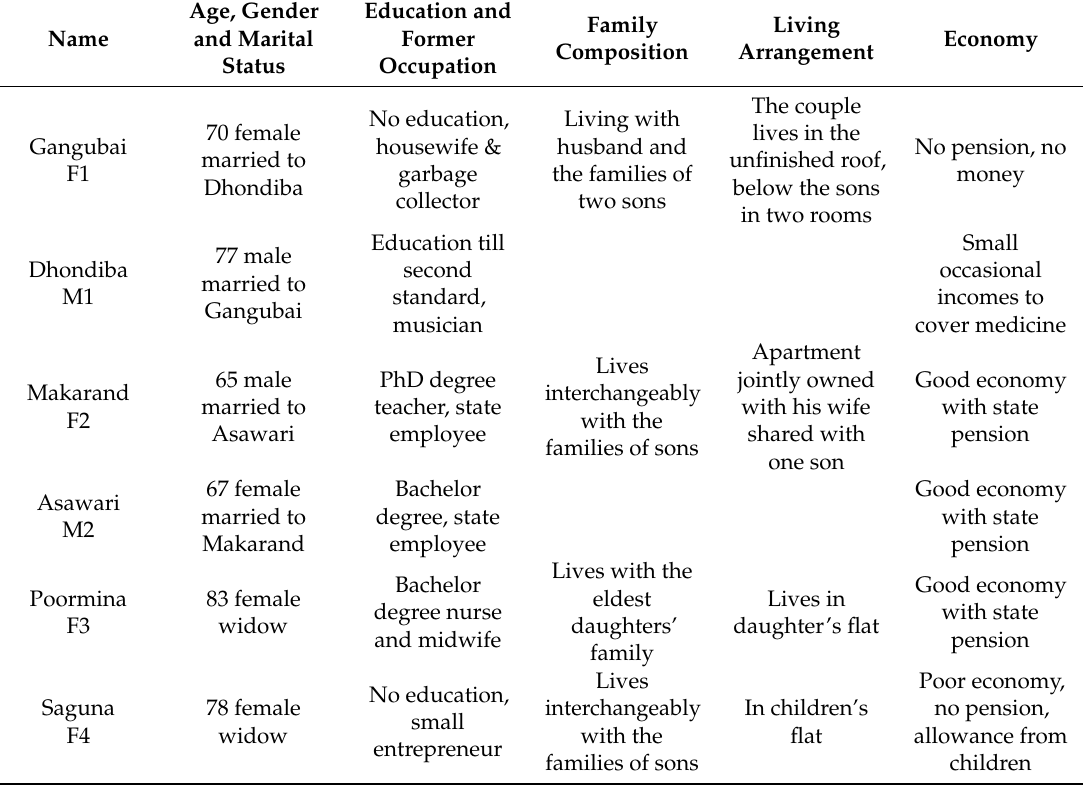
Table 1. Interviewed elderly living with their adult children in this